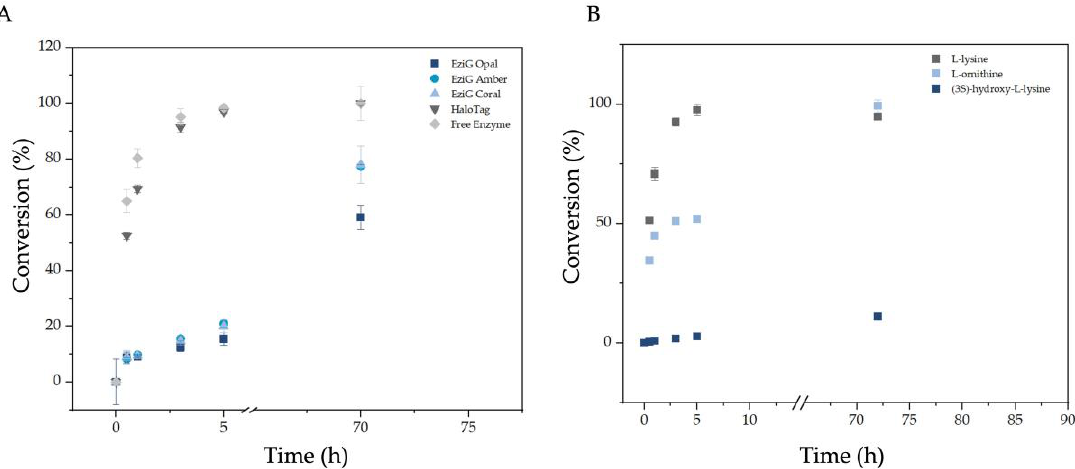
Figure 7. ( A ) Comparison of the conversion of free Sr LDC (with His-Tag), Sr LDC HaloTag ® -immobilized to HaloLink TM resin, and Sr LDC immobilized to EziG™ Opal, Amber, and Coral. ( B ) Comparison of the conversion of L-lysine, L-ornithine, and (3 S )-hydroxy-L-lysine with immobilized Sr LDC-HaloTag ® (0.1 mg mL −1 ). Reaction conditions: volume: 1 mL, 100 mM L -lysine or L -ornithine, 2 mM PLP in 100 mM HEPES, pH 7.0, in an overhead shaker at 35 °C under the exclusion of light. For (3 S )-hydroxy- L -lysine, the supernatant of the Ca KDO reaction was used (Figure 6A). Error bars are a result of two technical replicates or, in the case of the immobilized variants, of two independent immobilizations.